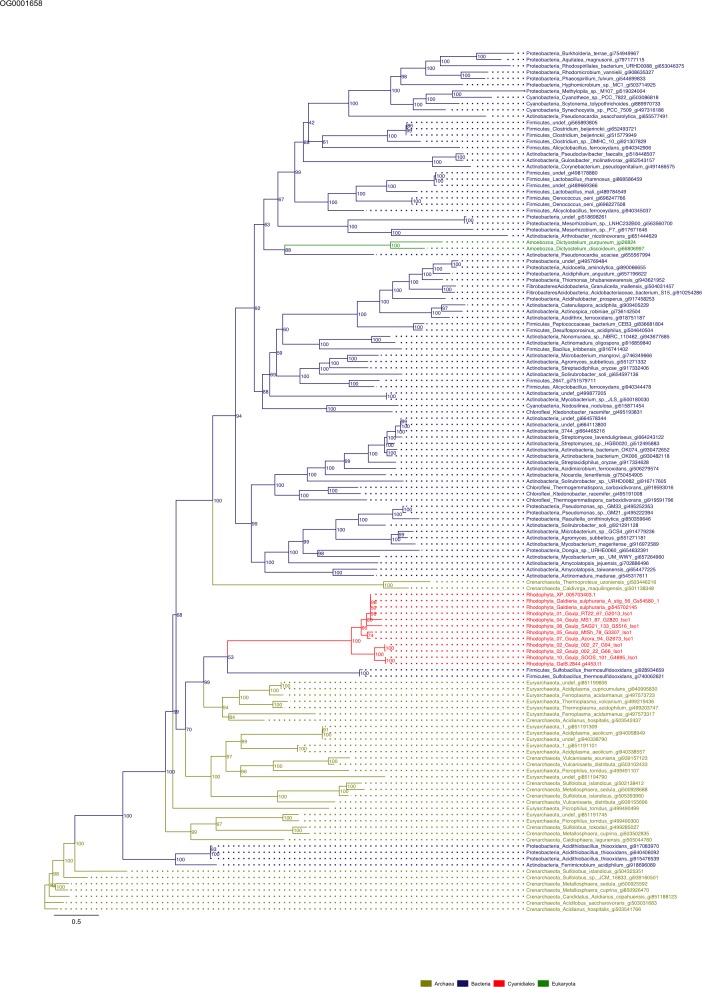
Sequence tree of orthogroup OG0001658.The tree is based on amino acid sequences. Archaea (yellow), Bacteria (blue), Cyanidiales (red), Eukaryotes including other red algae (green). Branches containing Cyanidiales sequences are highlited in red.